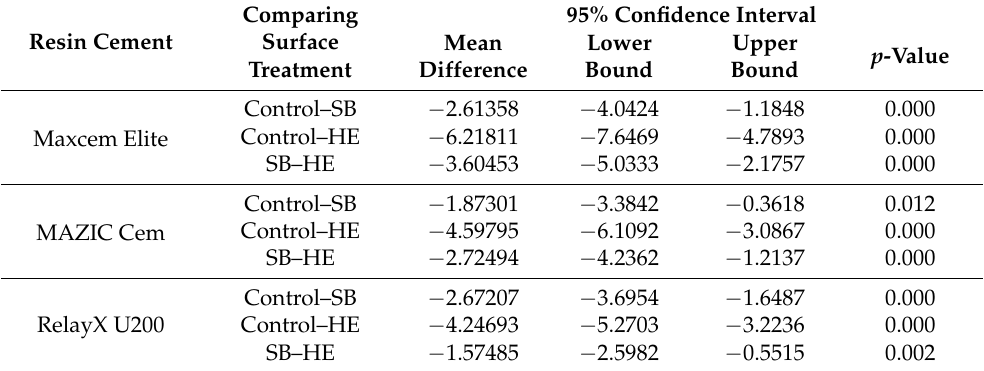
Table 4. Comparison statistics of shear bond strength between surface treatments and resin